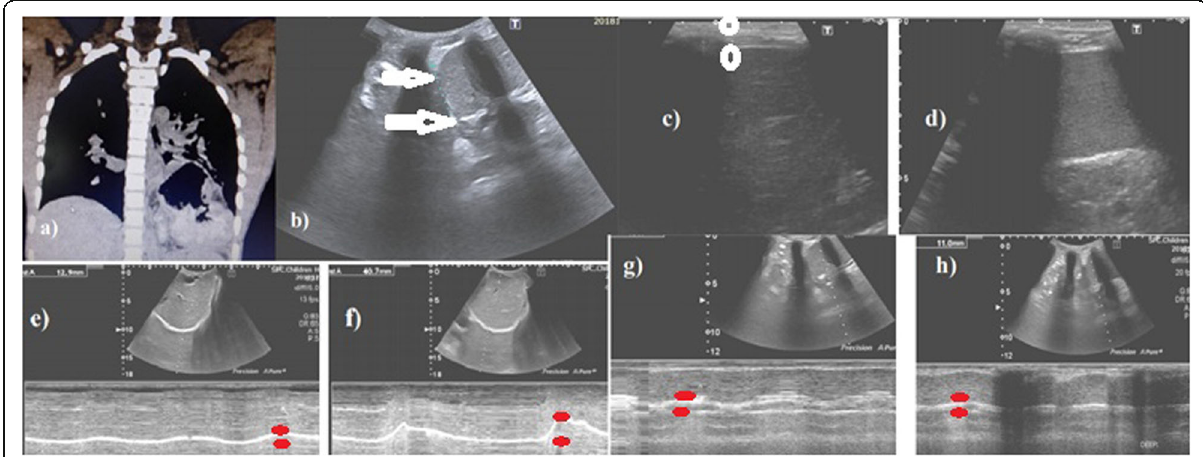
Fig. 2 a – h CT and US images for an 8-year-old male patient presented with a congenital diaphragmatic hernia for preoperative assessment. a Coronal reformatted CT of chest (mediastinal window) showing a large postero-lateral defect in the left hemidiaphragm through which a herniated bowel loops were seen in the left hemi thorax. b An US image — intercostal view — showing the defect that measure 6 cm (between the side arrows) as in CT and the echogenic bowel loops in the left hemithorax. c , d US images using the superficial probe through an intercostal view showing an average diaphragmatic thickness (RT = 2.4 mm, between the white circles/LT = 2.5 mm between the white dots) with an adequate thickening fraction (RT = 43%/LT = 48% ). e – h US images (for functional assessment of the diaphragm) — in intercostal views — showing within normal right diaphragmatic excursion in normal, deep breathing, and sniff test (= 1.2 cm in normal breathing ( e , between the red dots)/= 3.4 cm in deep breathing between the red dots/= 4 cm in sniffing ( f , between the red dots) and below normal left diaphragmatic excursion in deep breathing and sniff test (= 0.9 cm in normal breathing ( g , between the red dots)/= 1.1 cm in deep breathing ( h , between the red dots)/= 1.3 cm in sniffing between the red dots); these findings were relevant to a left hemidiaphragmatic weakness with a bowel containing